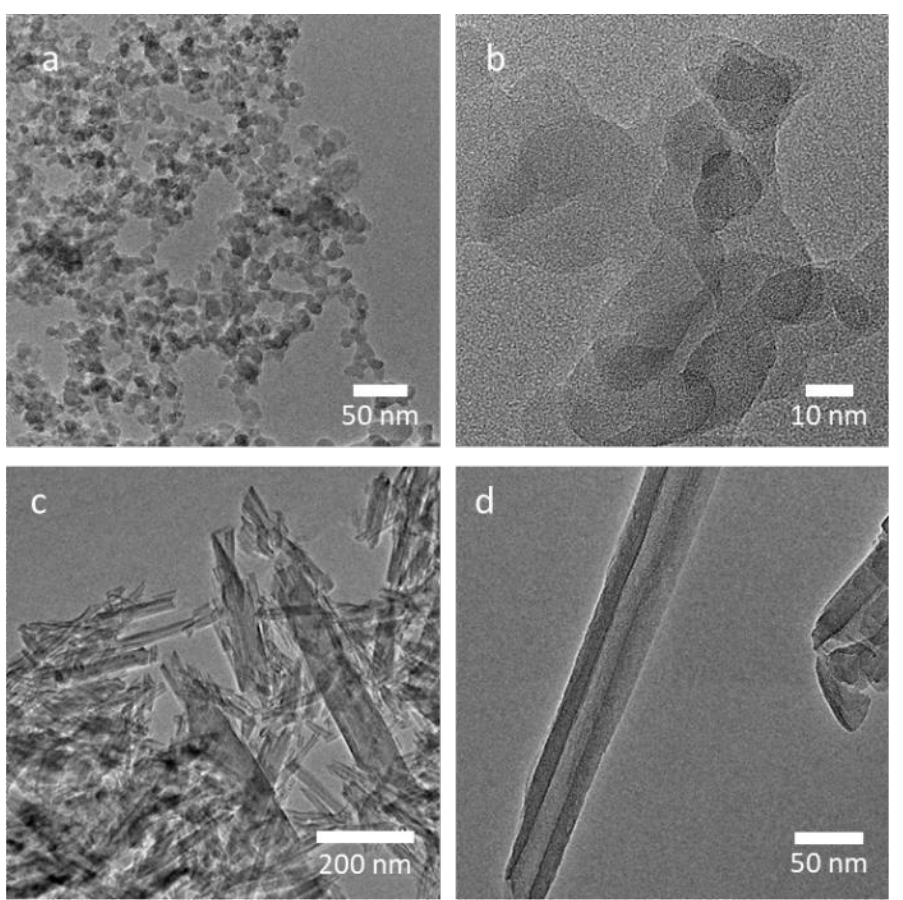
Figure 2. TEM micrographs of the ( a , b ) silica and ( c , d ) HNT nanomaterials.